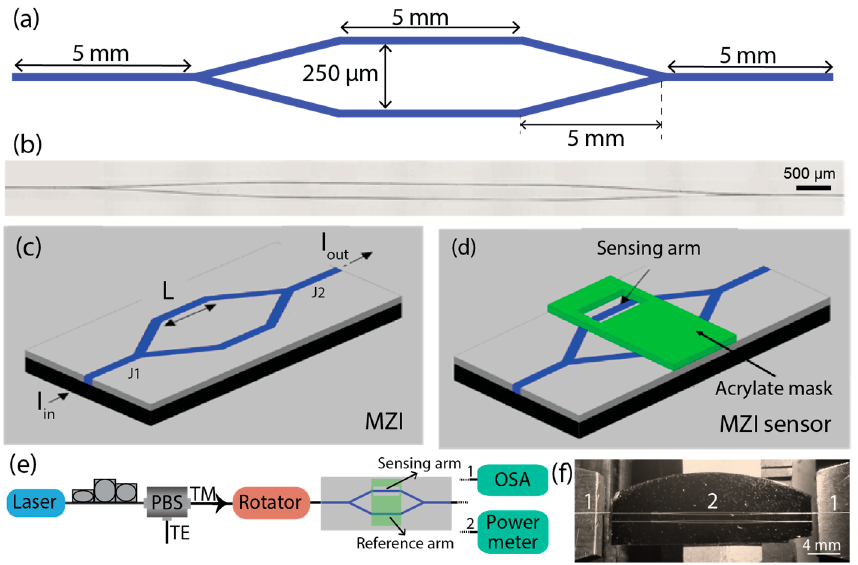
Figure 1. ( a ) General view and detailed dimensions of the Mach-Zehnder interferometer (MZI); ( b ) optical image showing the MZI structure patterned on the surface of a di-ureasil film; ( c , d ) scheme of the bare biosensor before and after the liquid container, respectively; ( e ) experimental setup and ( f ) photography of the alignment system used for the optical measurements of the MZI: (1) the optical fibers; (2) MZI patterned region.